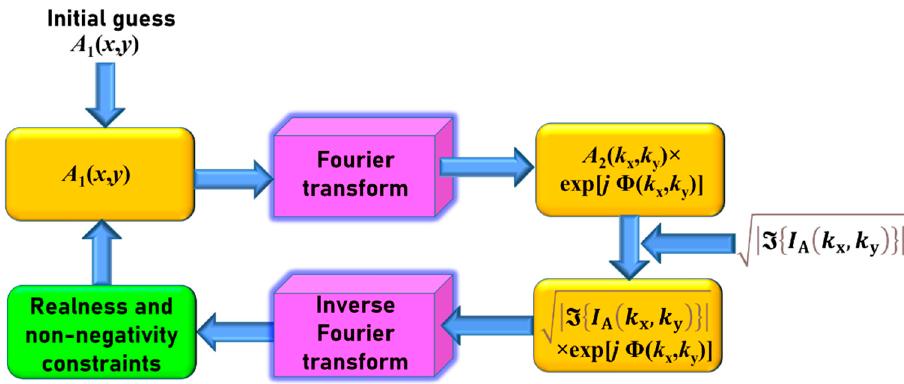
Figure 2. Block diagram of the phase-retrieval algorithm.